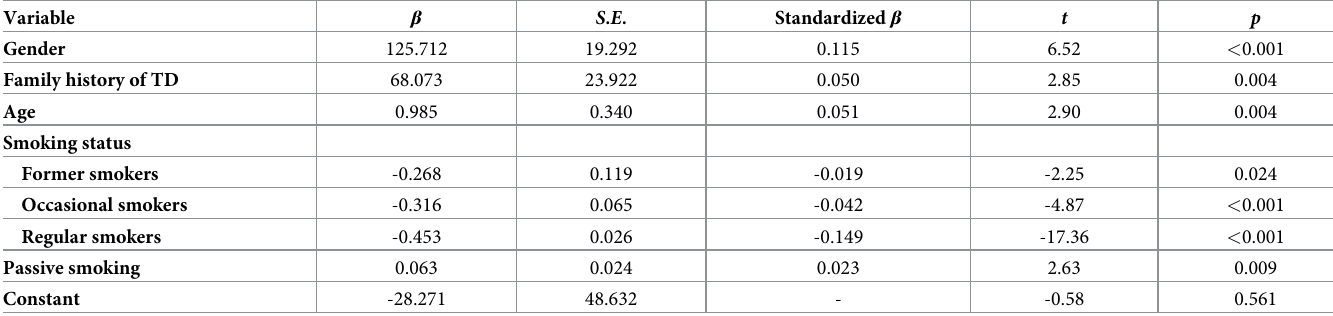
Table 6. Multivariate analysis of factors related to Ln TgAb.